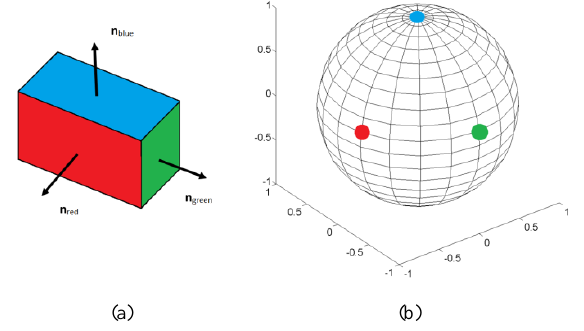
Figure 2 : Gaussian image of three connected planar surfaces: (a) Arrows indicate surface normal vectors (n red , n green , n blue ) to the respective surfaces; (b) All points belonging to one particular surface are mapped to same identical point in GI (ideal